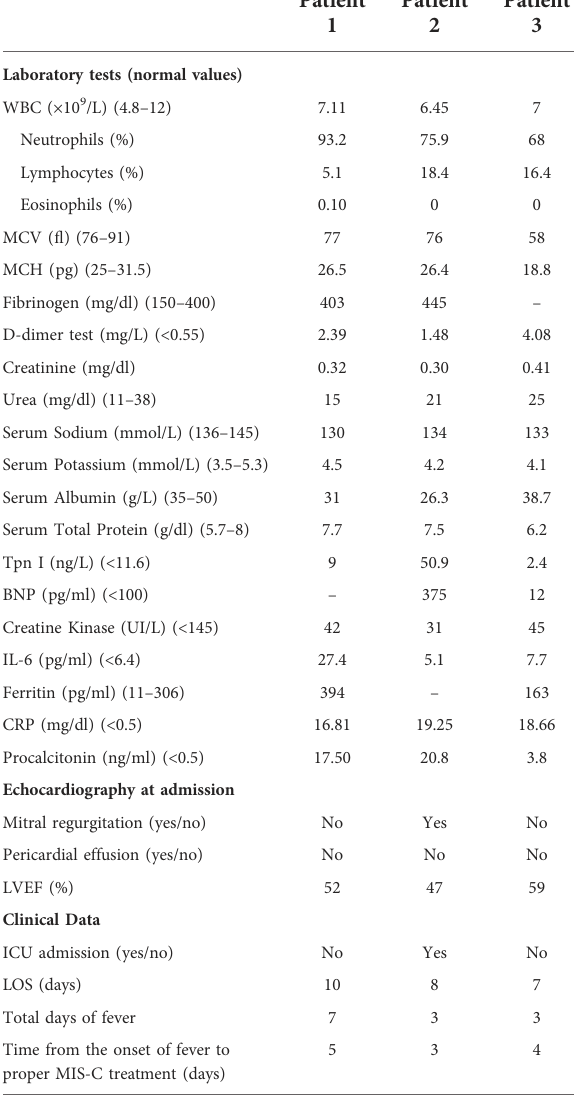
TABLE 1 Laboratory tests, echocardiographic, and clinical